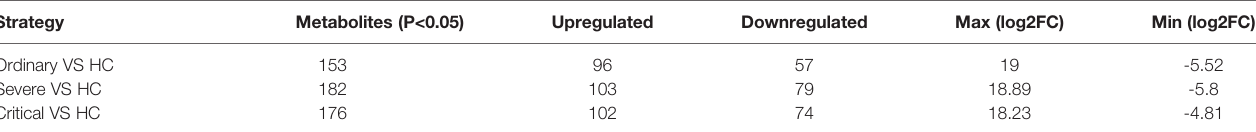
TABLE 1 | Metabolomic alternations associated with clinical symptoms of COVID-19 compared with healthy control (HC). Strategy